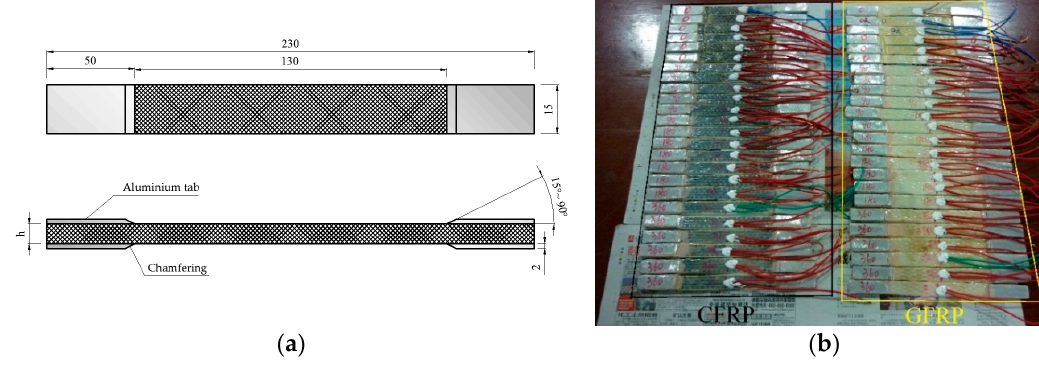
Figure 1. Configuration of FRP samples: ( a ) Schematic diagram; ( b ) photos. Table 1. The properties of FRP under different wet-dry cycling exposures.